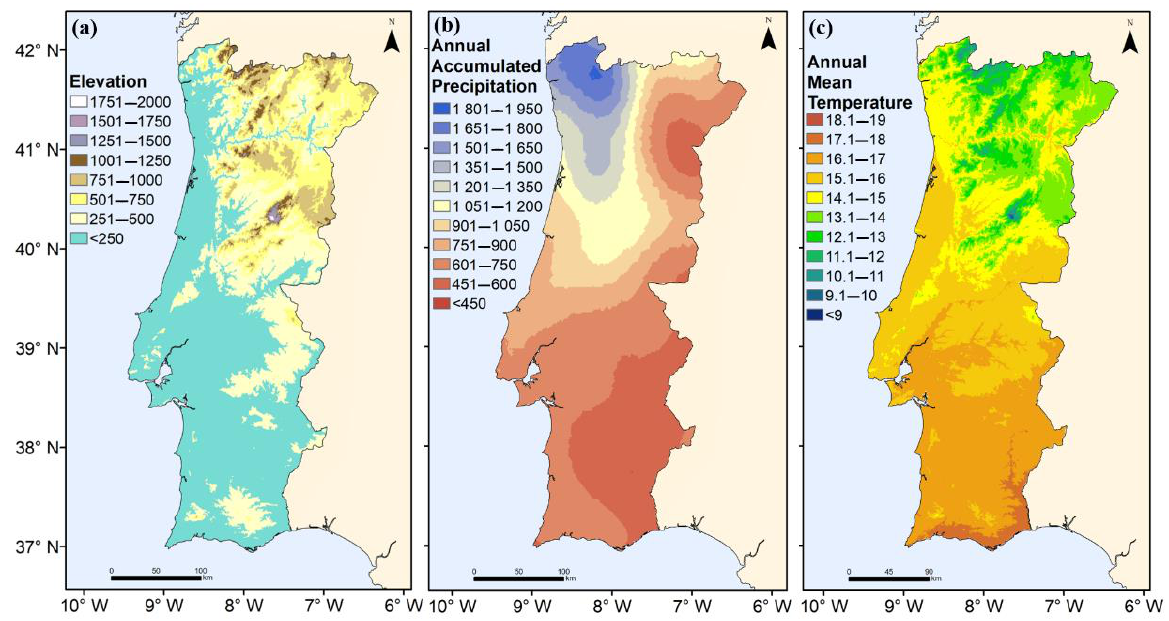
Figure 2. Mainland Portugal characterization of ( a ) elevation; ( b ) annual accumulated precipitation; ( c ) annual mean temperature.